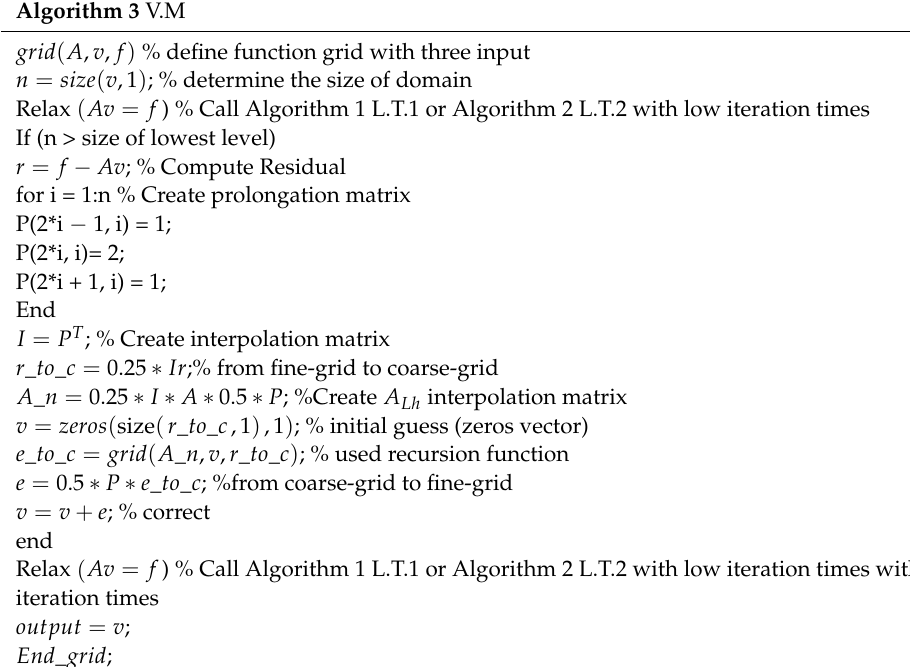
Algorithm 3 V.M